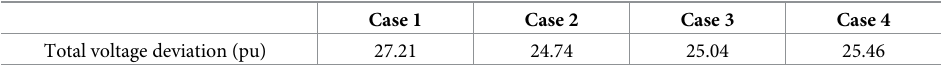
Table 5. Comparison of total voltage deviation in different